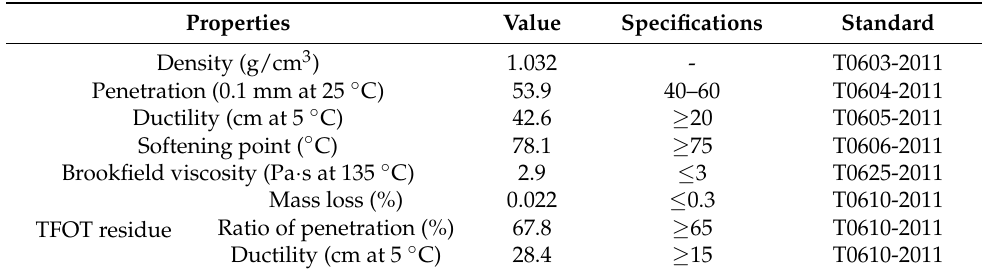
Table 1. Basic properties of SBS modified asphalt.